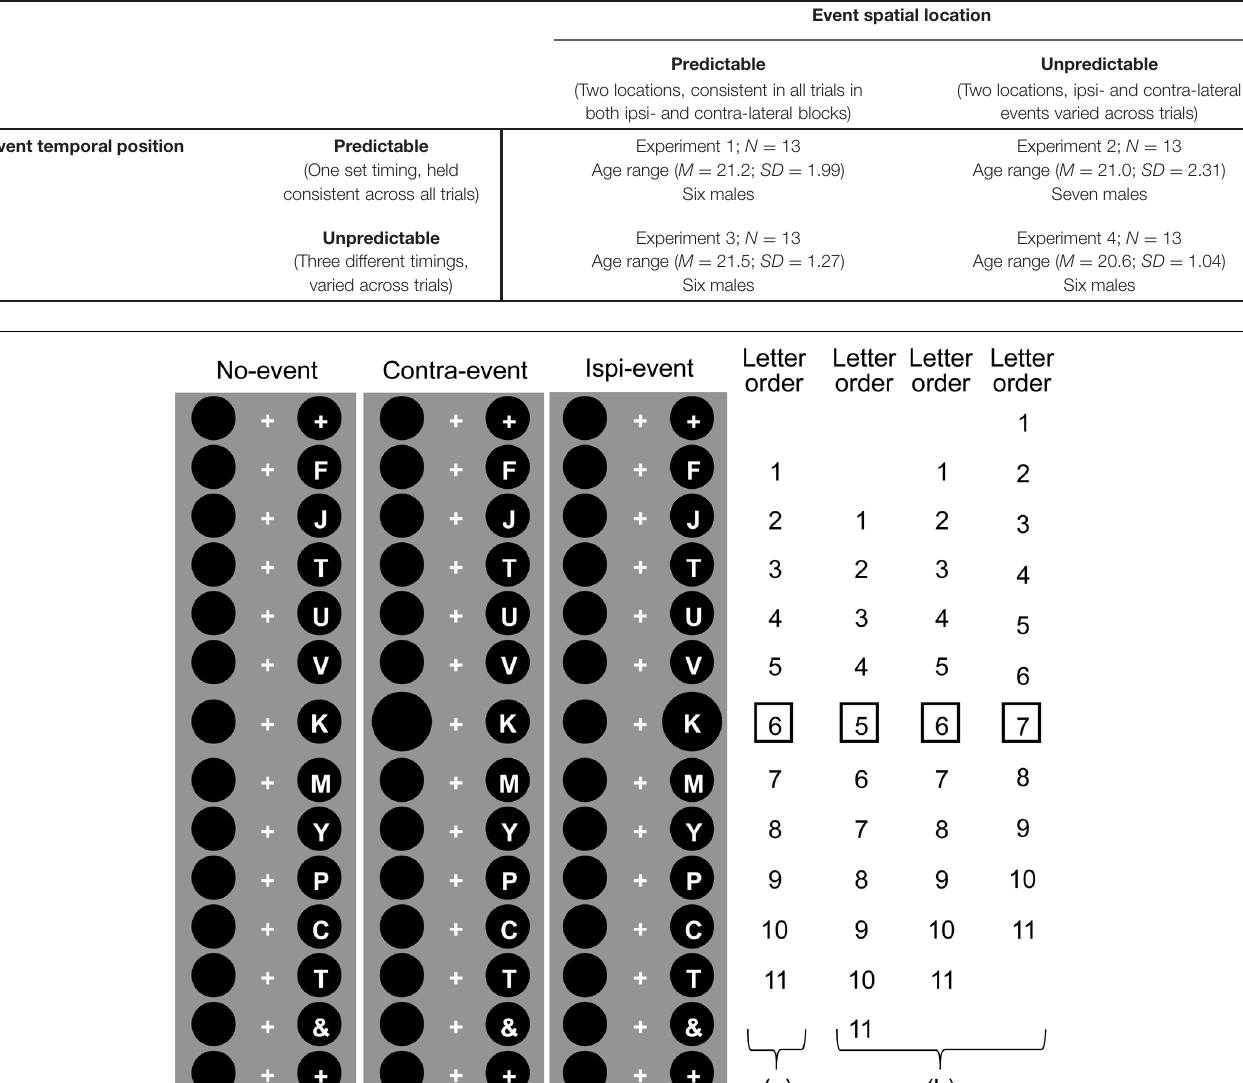
TABLE 1 | Temporal and spatial 2 × 2 event predictability design of the four experiments.